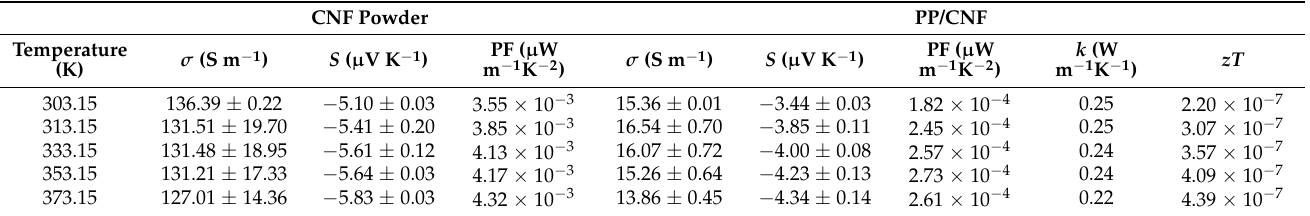
Figure 6. Electrical conductivity (squared symbols, black) and Seebeck coefficient (triangle symbols, red) as function of temperature of CNF powder and PP/5 wt.% CNF composite. The black and red dash lines represent the fitting with Equation (1) and Equation (2), respectively. Table 3. Thermoelectric properties of CNF powder and PP/5 wt.% CNF composite as function of